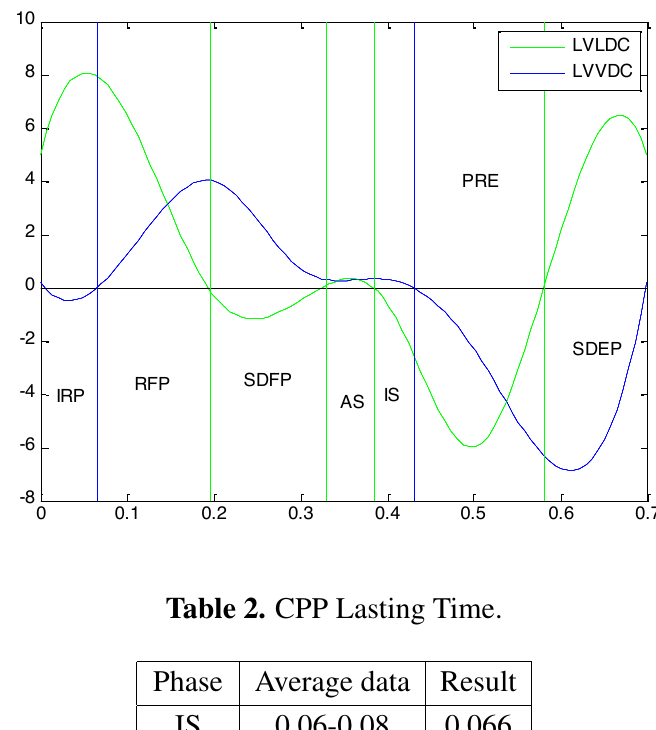
Figure 3. CPP partition in cardiac cycle.